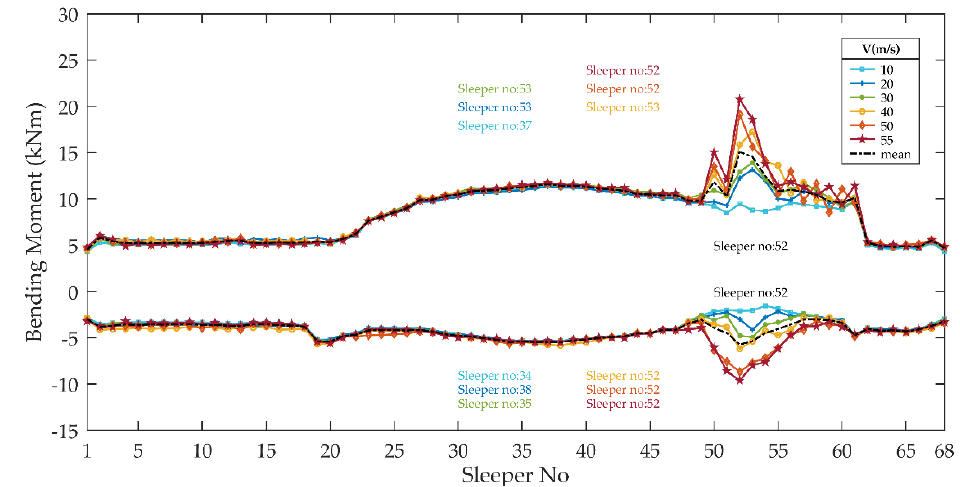
10 of 24 Figure 5. Multibody responses: ( a ) Dynamic factors for two cases: track with no irregularities and with irregularities; ( b ) contact forces for minimum and maximum speed. As aforementioned, both numerical studies and field measurements [7,11,32,40] show that the highest contact forces and vertical accelerations of the wheelsets are observed at the crossing panel, particularly at the crossing nose. The common insight in these studies is that the most critical part of a turnout is the crossing panel. Nevertheless, such a conclusion seems inaccurate; in [31] where it is shown that sleepers at closure panels are subjected to the highest bending moments under moving constant loads. Interestingly, the findings in the previous section confirm both results, which show that the critical section could be either at closure panel or crossing panel based on vehicle speed. To understand the origin of the discrepancy between studies, it is crucial to investigate the longitudinal bending moment distributions of turnout components for different vehicle speeds. In Figure 6, the longitudinal bending moment distribution is displayed for a case when the vehicle runs over a track without irregularities. The bending moment distribution shows that maximum bending moments at lower speeds gradually increase with the sleeper length, with the exception of a small drop at the sleepers under the crossing nose. The relatively lower bending moments at the crossing panel could be a consequence of the increased total rail stiffness, which evenly distributes the load between sleepers. The distinct property of Figure 6 is that significant variations could be observed only at the crossing panel with no track irregularities. As can be seen from Figure 6, maximum positive bending moments as well as maximum negative bending